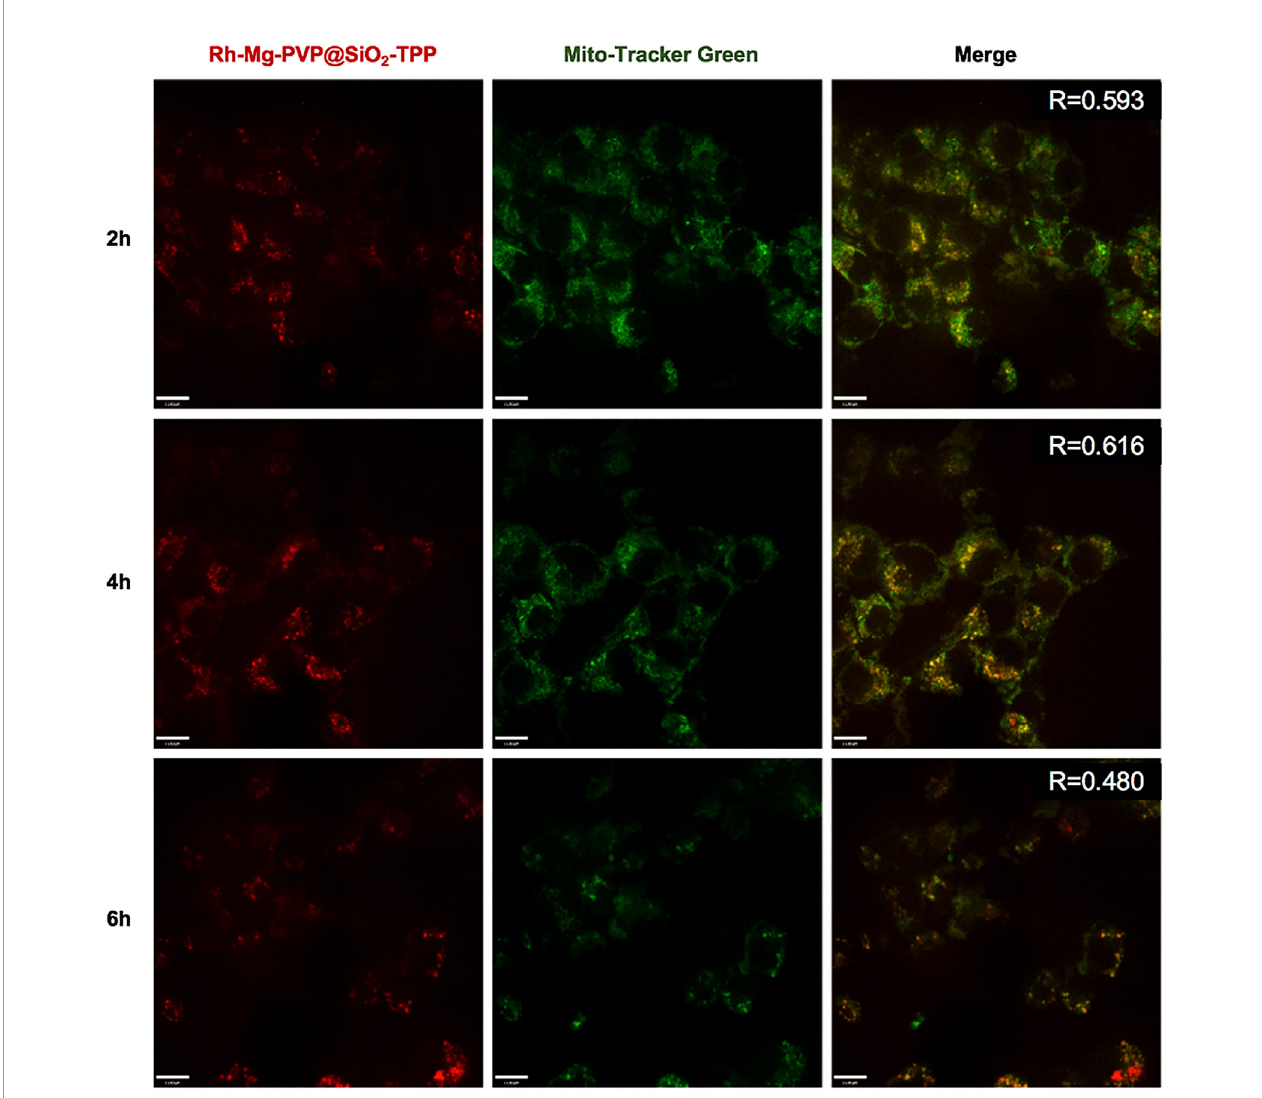
FIGURE 5 | Co-localized images of live BV2 cells incubated with 200 m g ml − 1 Rh-Mg-PVP@SiO 2 -TPP NPs for different times at 37°C and then incubated with MitoTracker Green for 10 min at 37°C. Red channel for Rh-Mg-PVP@SiO 2 -TPP NPs ( l ex = 561 nm), green channel for commercialized MitoTracker Green ( l ex = 488 nm), co-localization of green and red channels. Scale bar represents 11 m